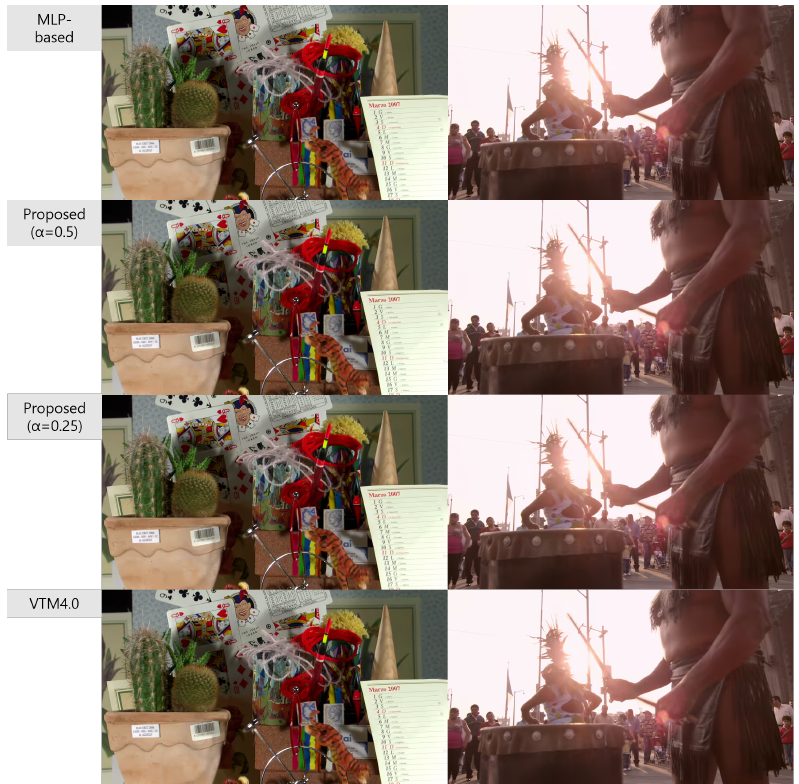
Figure 9. Decoded frames from Cactus and RitualDance videos yielding the worst ∆ EncT results presented in Table 8 when QP =